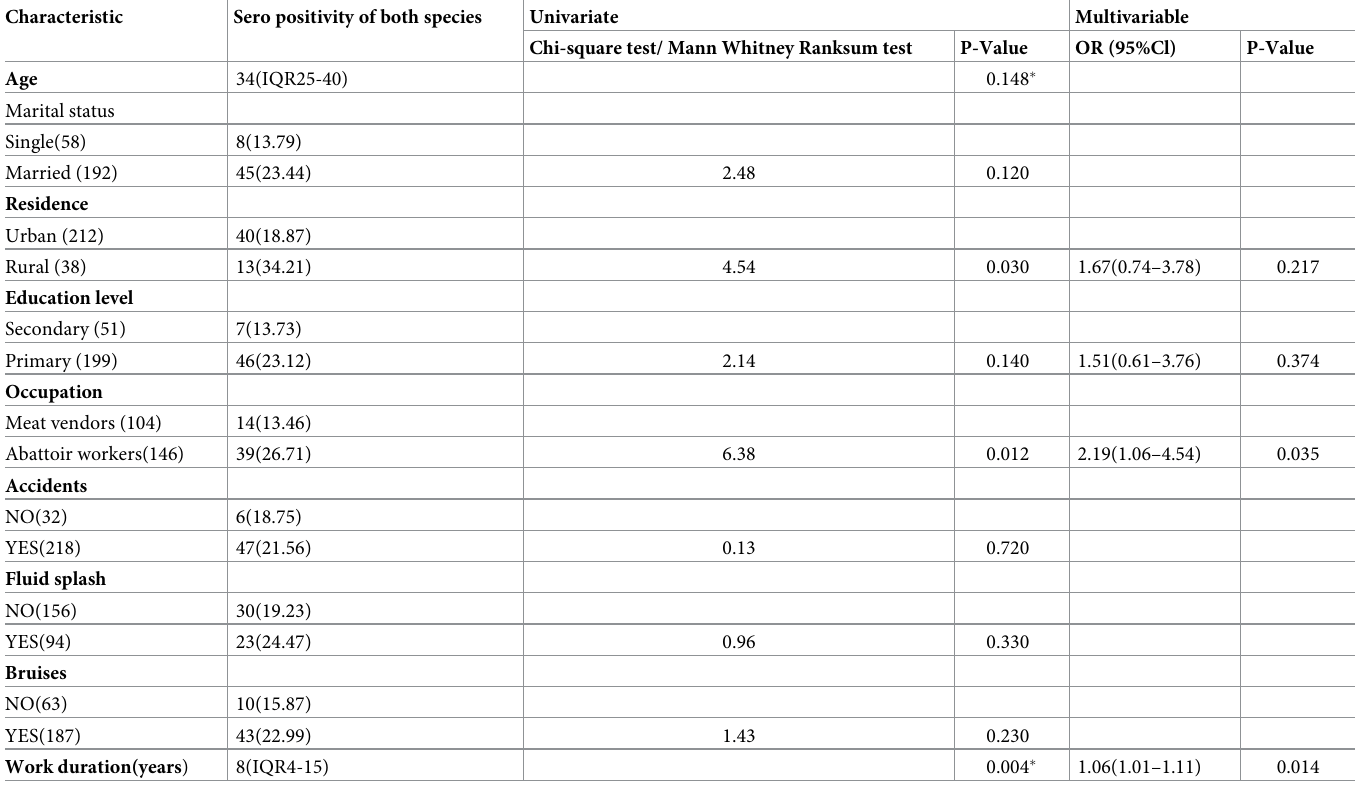
Table 4. Factors associated with presence of antibodies for both species ( B . melitensis and B . abortus )among study participants between May and July